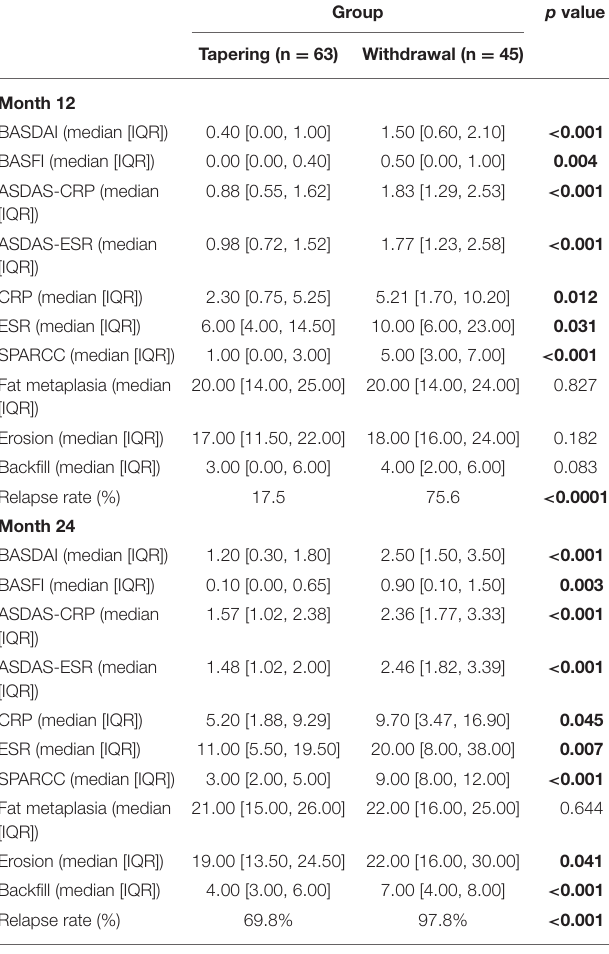
TABLE 1 | Demographic and clinical characteristics of patients with axSpA at baseline.